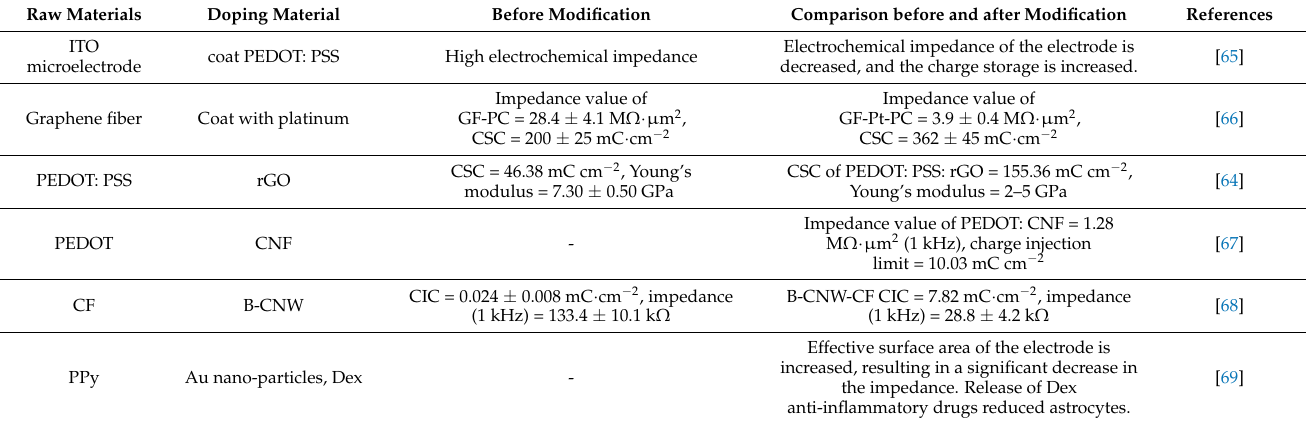
Table 2. Doped electrode